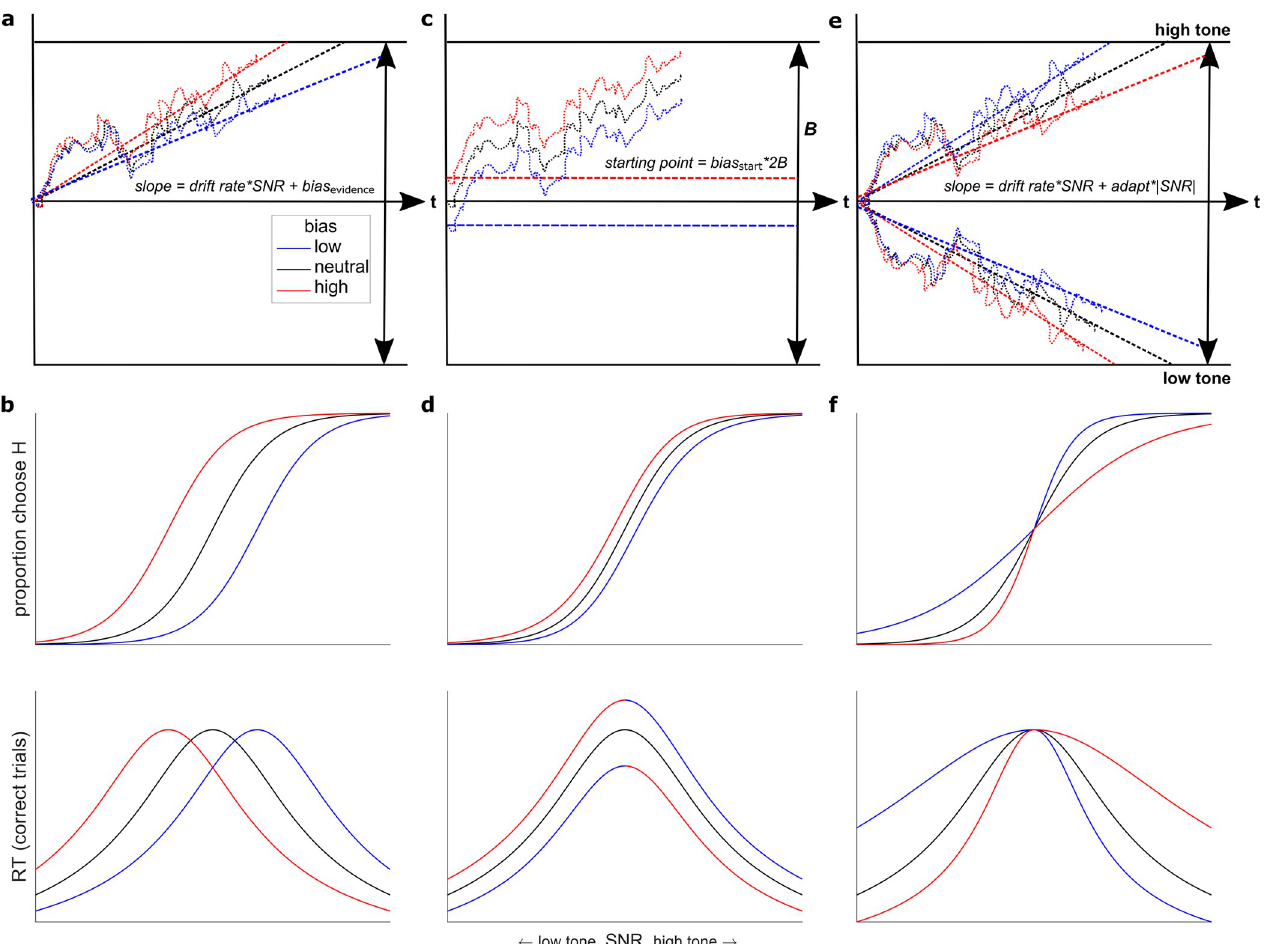
Fig 4. Simulated DDM bias terms (top) and their predicted, distinguishable effects on psychometric (choice; middle) and chronometric (RT; bottom) functions. A A bias implemented as an additive offset to the drift-rate term, which shifts the slope of the decision variable in the direction favored by the bias. B This “evidence-accumulation bias” causes lateral shifts in the psychometric and chronometric functions, corresponding to more and faster choices in the direction of the bias. C A bias implemented as a shift in the starting point of evidence accumulation toward the bound favored by the bias, implying that less evidence is needed to make a bias-congruent choice. D This “starting-point bias” causes smaller lateral shifts in the psychometric function than for the evidence-accumulation bias and vertical asymmetries in the chronometric function (see the discontinuity at SNR = 0), such that RTs are faster (slower) for prior congruent (incongruent) choices. E An adaptation-like bias that affects the slope of the decision variable in a manner that varies with the absolute value of the test-tone SNR. F For the stimulus-based condition, this term, which is absent at SNR = 0 and increases with increasing |SNR| of the test tone, shifts the slope of the decision variable away from the frequency of the tones heard prior to the test tone and thus causes more and faster choices to the frequency opposite the most-recently heard pre-test tones. A, C, E Dotted lines: example evolutions of the decision variable for a single trial with a given bias (see legend). Dashed lines: average slope of decision variable. t = time. In C , B = total bound height/2. B, D, F Simulated choice (top) and RT (bottom) data from an analytical solution to the DDM